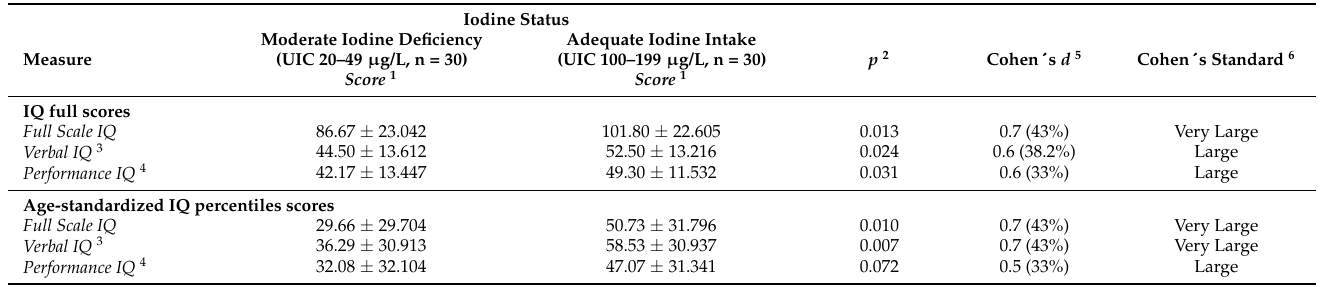
Table 2. WISC-III IQ full scores and age-standardized IQ percentiles scores in schoolchildren for moderate iodine deficiency and adequate iodine intake